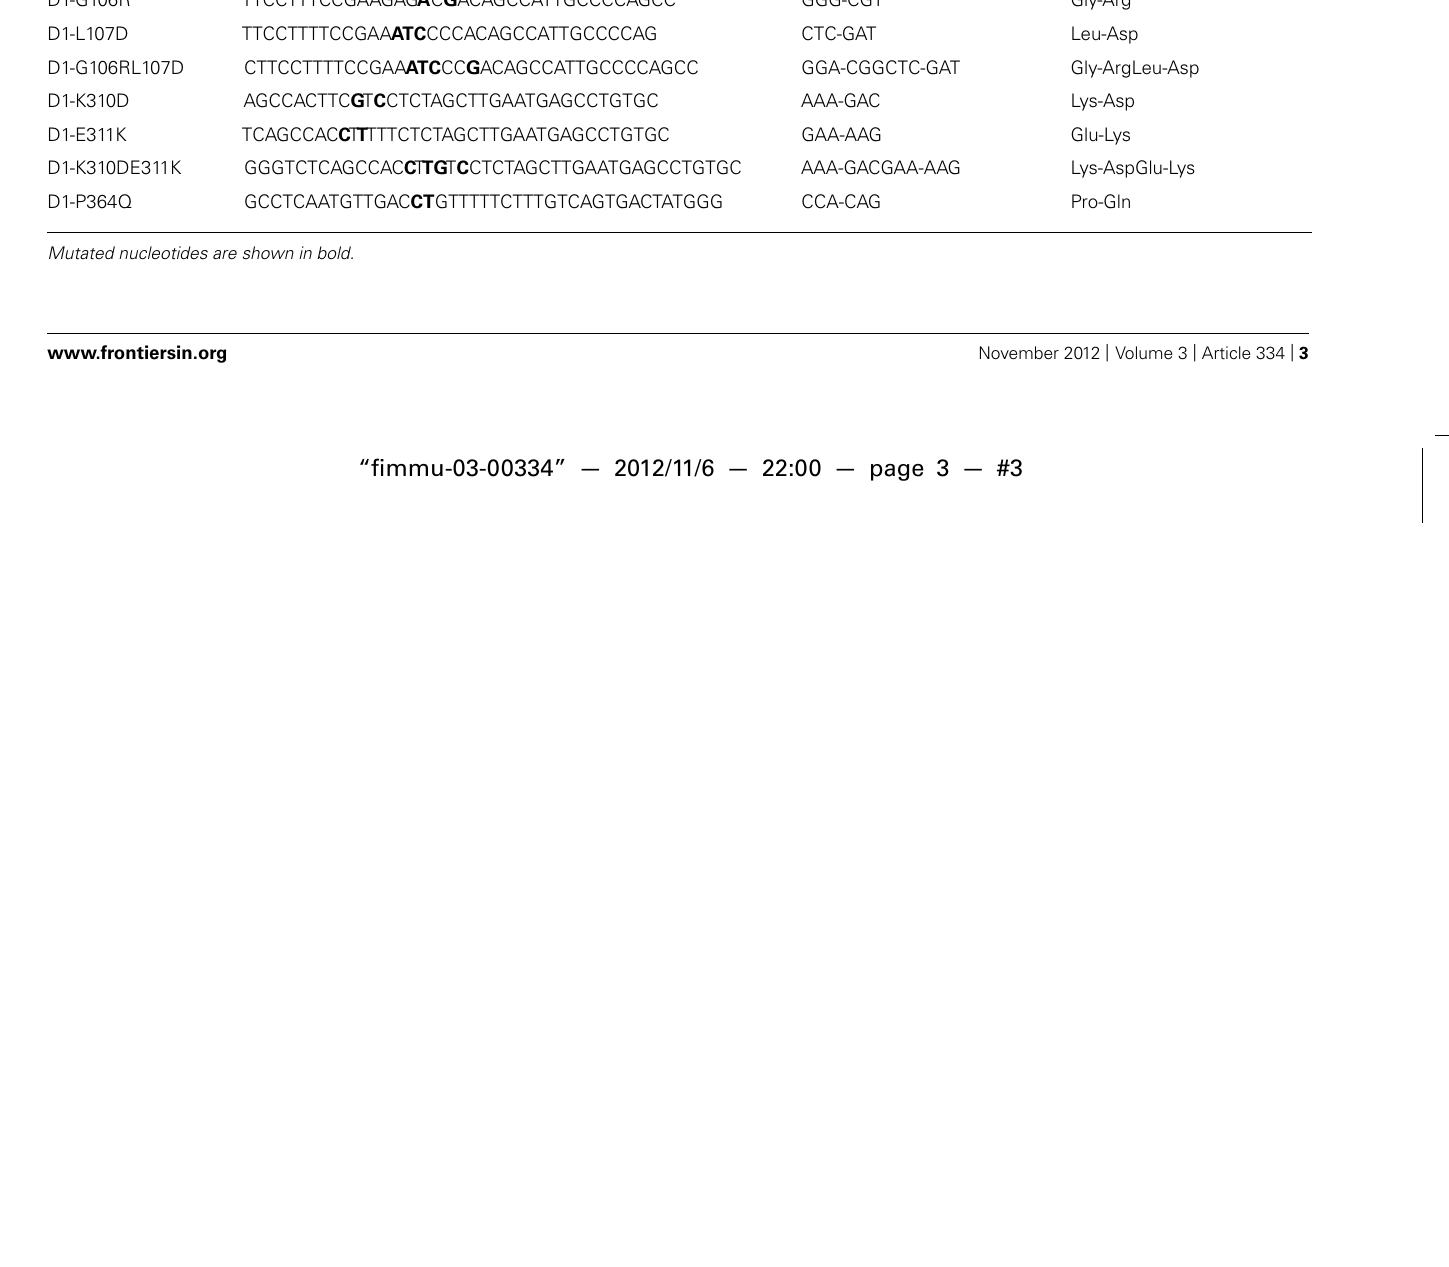
Table 1 | Nucleotide sequences of mutagenic primers. Primer Primer Sequence (5 (cid:2) -3 (cid:2) )